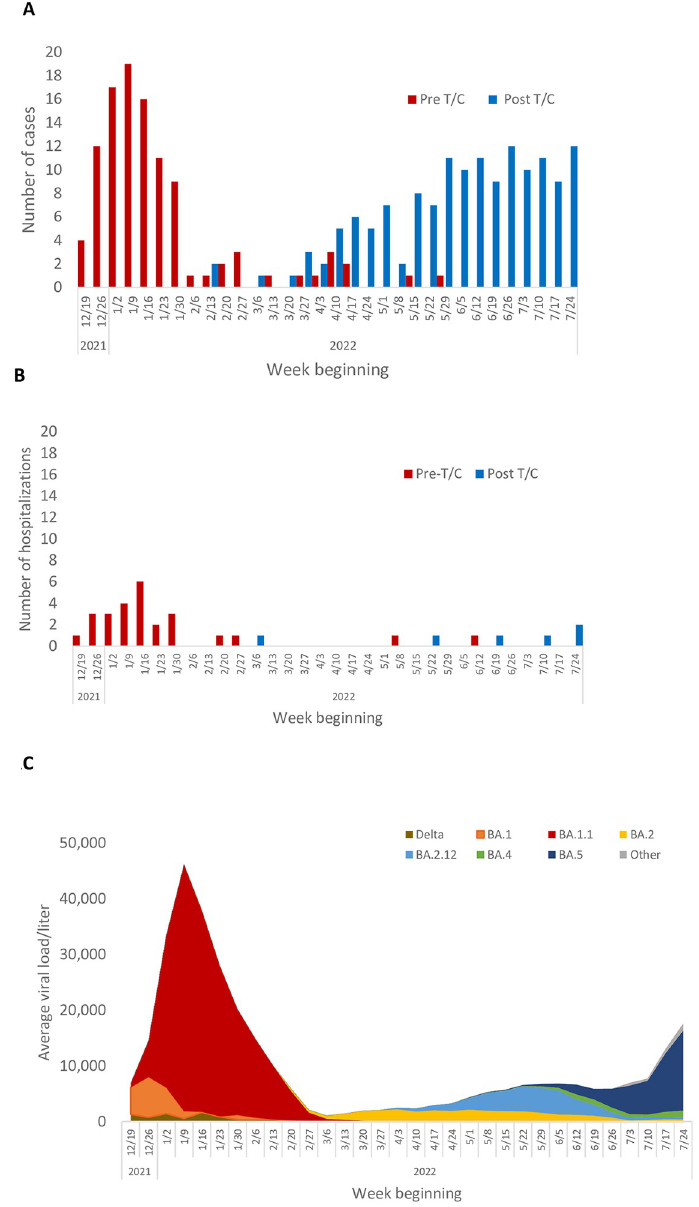
Fig 1. A. Cases of COVID-19 by week and T/C status at the time of COVID-19 diagnosis, UC San Diego Health, December 2021—July 2022. B. Hospitalizations for COVID-19 by week and T/C status at the time of COVID-19 diagnosis, UC San Diego Health, December 2021—July 2022. C. Average weekly SARS CoV-2 wastewater viral loads/ liter by variant, San Diego County, December 2021 –July